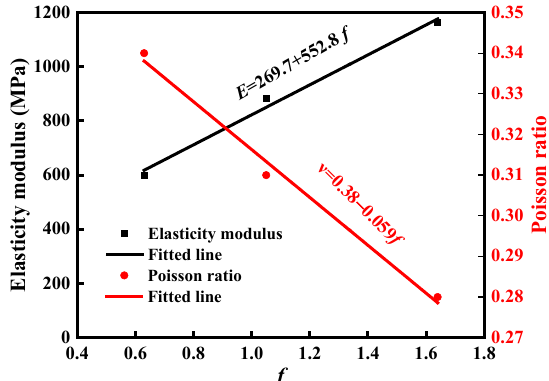
Figure 3. Relationship between coal mechanical parameters and f value.